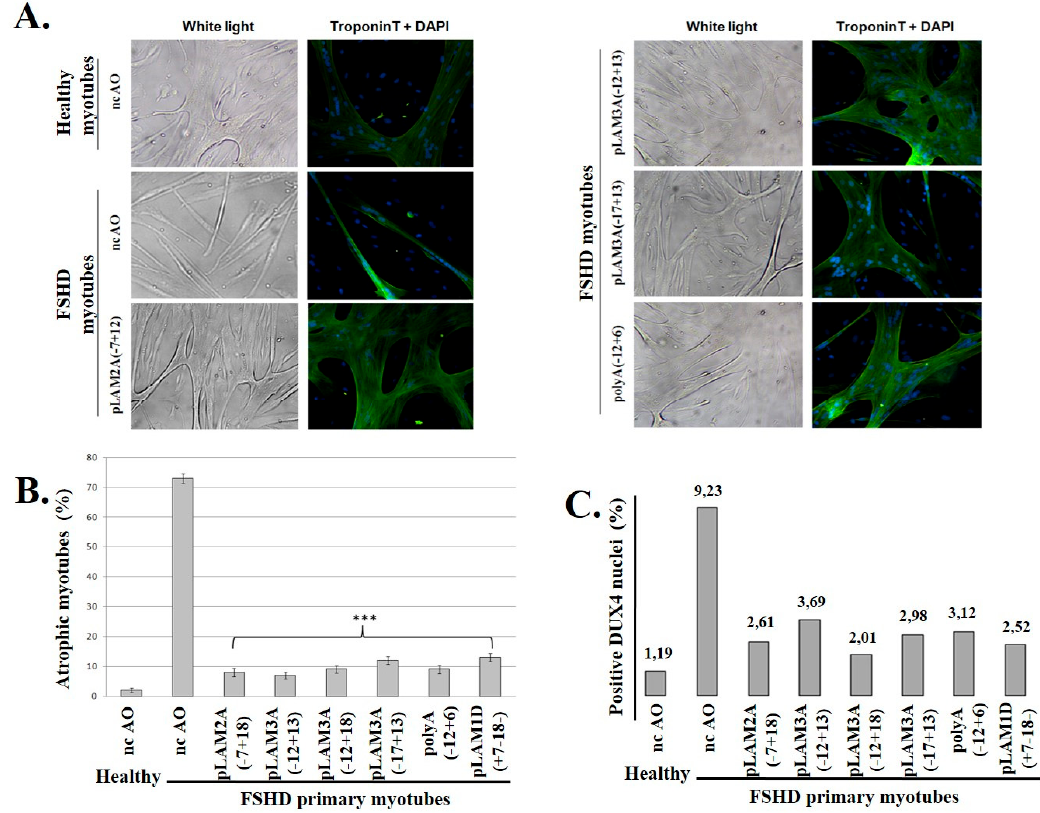
Figure 3. Treatment of FSHD myoblasts with antisense oligonucleotides against DUX4 prevents the formation of myotubes with the atrophic phenotype. ( A ) Primary healthy or FSHD myoblasts were transfected with either the negative control AO (nc-AO) or the indicated AOs targeting DUX4 mRNAs (AO positions shown in Figure 2), and differentiation was induced 4 h later. After 8 days, cells were observed under white light before processing to detect troponin T through immunofluorescence (green). The nuclei were stained with DAPI; ( B ) The efficacy of the AOs used in ( A ) and two additional ones was evaluated based on the proportion of atrophic myotubes (caused by DUX4 expression, and observed in the ncAO-treated cells) in the culture. Myotubes were counted from at least 10 random fields: those with a width <20 µ m were considered “atrophic”. The percentage of atrophic to total myotubes is expressed as the mean ± SD; ( C ) DUX4 was detected by immunofluorescence (MAb 9A12; not shown). The number of DUX4-positive nuclei was counted in 10 fields in healthy control or FSHD myoblast cultures following treatment with the indicated AOs. The percentage of DUX4-positive nuclei among total nuclei (DAPI staining) was calculated and is reported in the graph. The significance of the differences between experiments with each individual AO compared to the ncAO, was evaluated using Student’s t -test. *** p -value < 0.001.